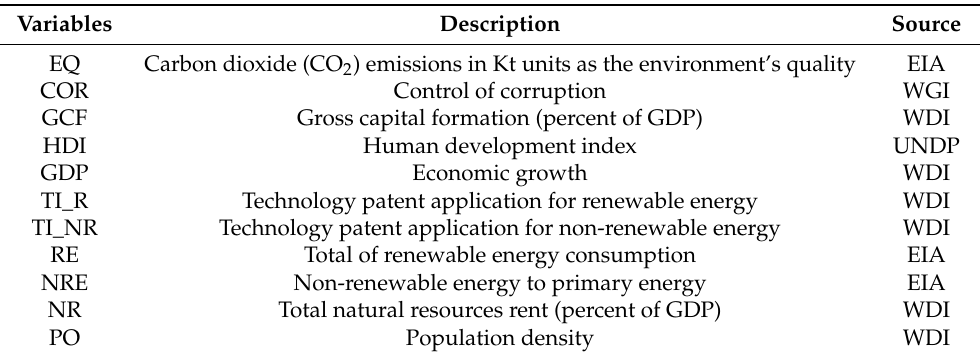
Table 1. The variables and data